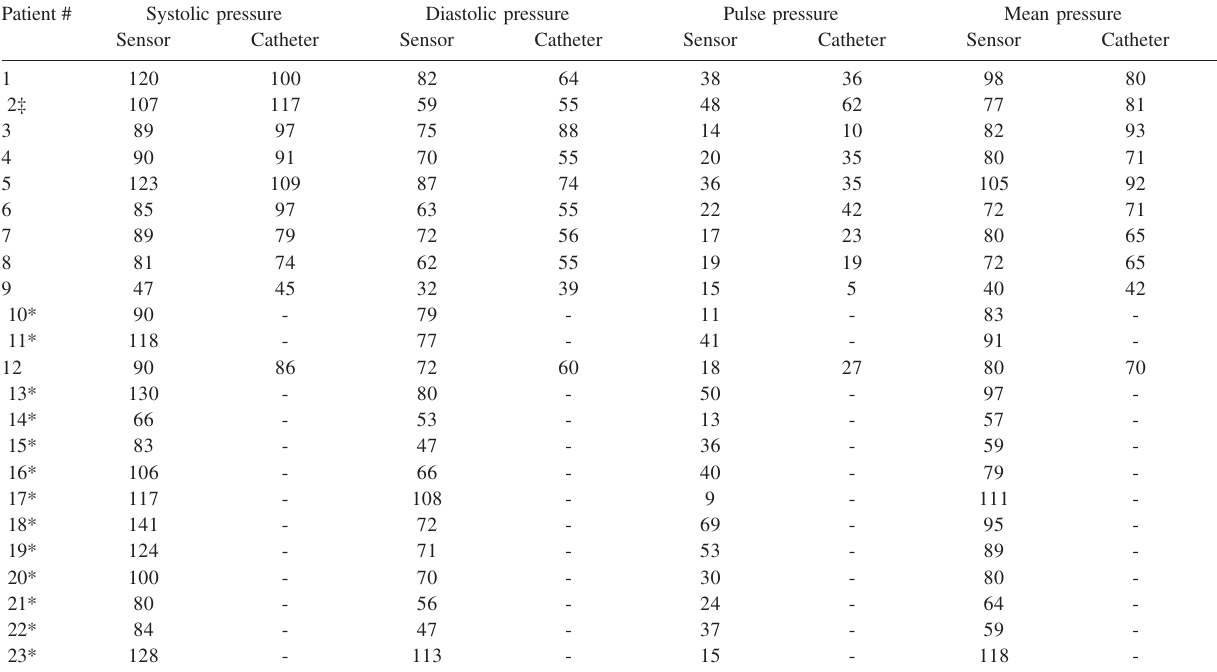
Table 3 - Intrasac pressure measurements for Reading 2